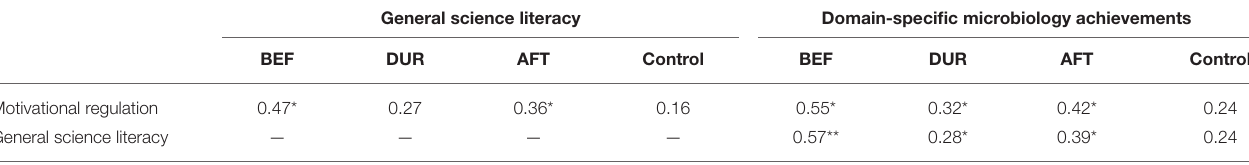
TABLE 8 | Correlations (Fisher’s transformation of r to Z) among dependent variables in the four research groups at time